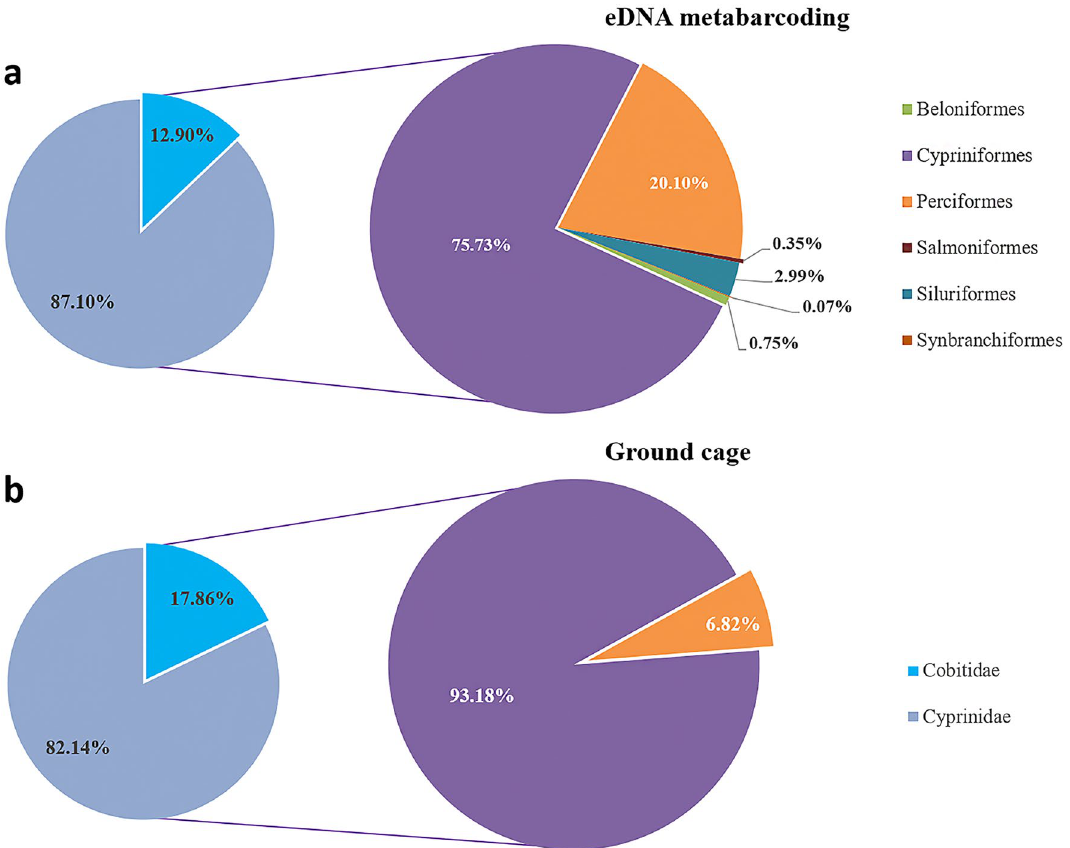
Figure 3. Relative abundance of fish at the order level detected by the two methods and relative abundance of occurrence at the family level corresponding to